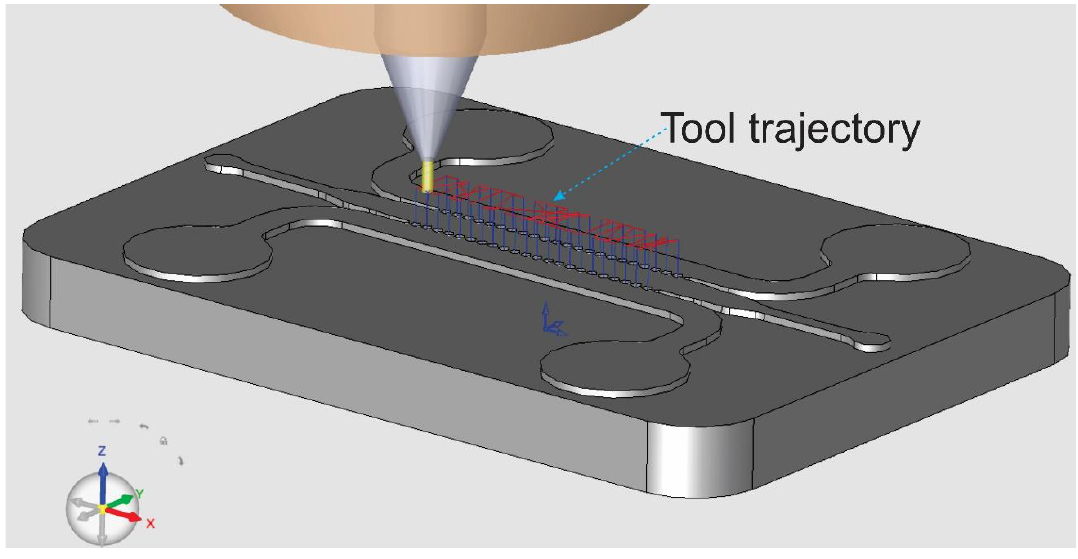
Figure 7. Captured image from Cimatron 14 on the simulation process of fabricating a master mold for injection molding of circular micro-post tissue chip. For the simulation video, see Supplementary Material, Media S3.